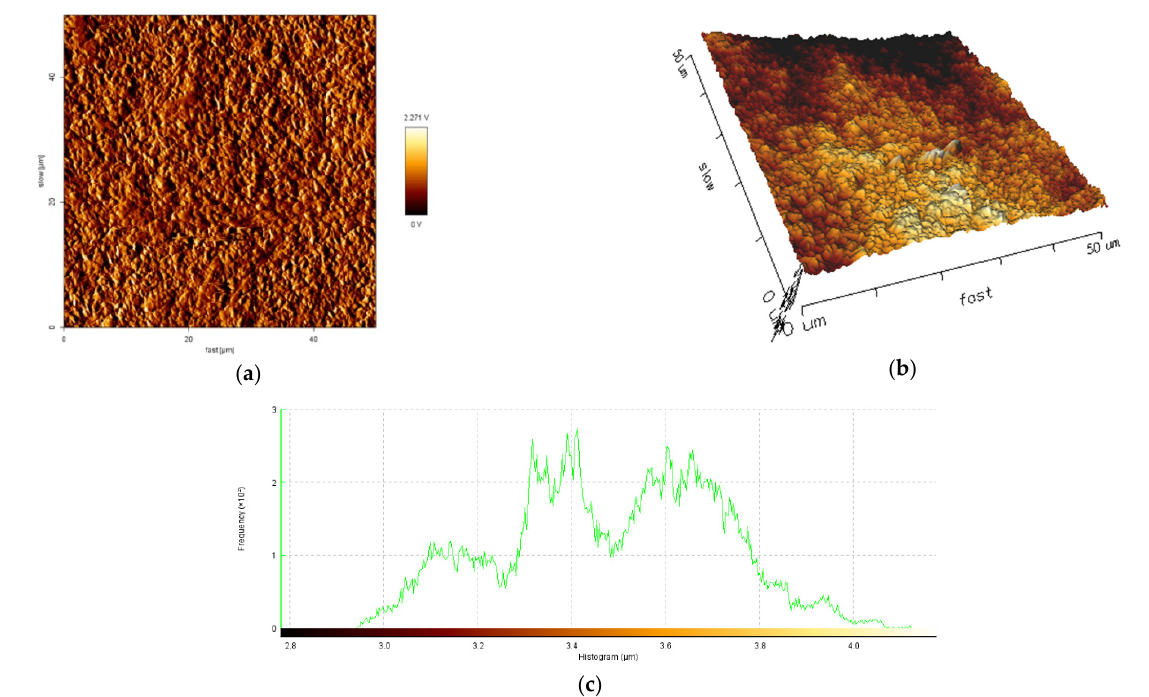
Figure 6. 50 × 50 μ m 2 AFM images of sample C: ( a ) 2D image; ( b ) 3D image; ( c ) histogram of the scanned surfaces.